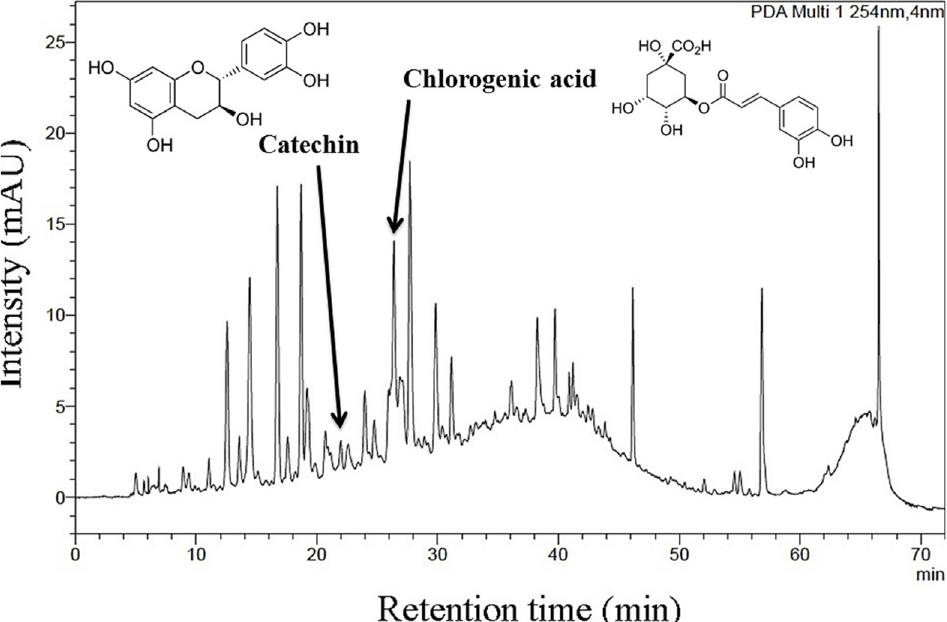
FIGURE 3 - Chromatographic profile of the ethyl acetate phase of the aerial parts of Cyperus iria L. (EAFCIAP) at 254 nm wavelength.